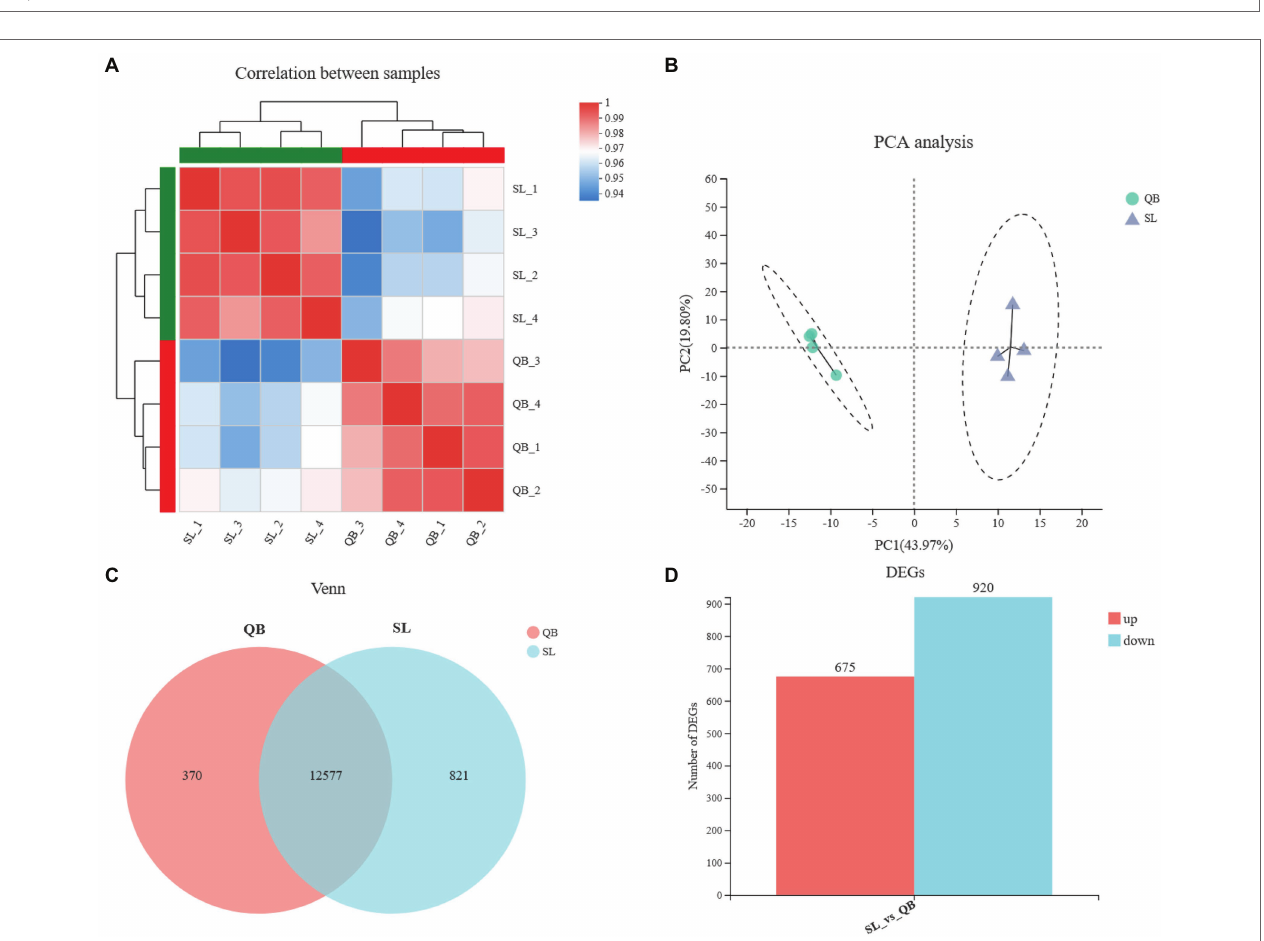
FIGURE 3 | Statistical analysis of sequencing data of QB-G and SL-N. (A) Pearson correlation analysis. The right and bottom side are sample names, the left and top side are sample clusters, and different colors represent the degree of correlation between two samples. (B) Principal component analysis based on gene expression. The distance between samples represents the degree of similarity, the horizontal and vertical axes indicate the contribution of principal component 1 (PCA1) and principal component 2 (PCA2) to the differentiated samples, respectively. (C) Venn analysis. Numbers represent genes that are common or unique between groups. (D) Statistics of differentially expressed genes (DEGs). Red group represents upregulation, blue group represents downregulation, and the vertical axis represents the number of